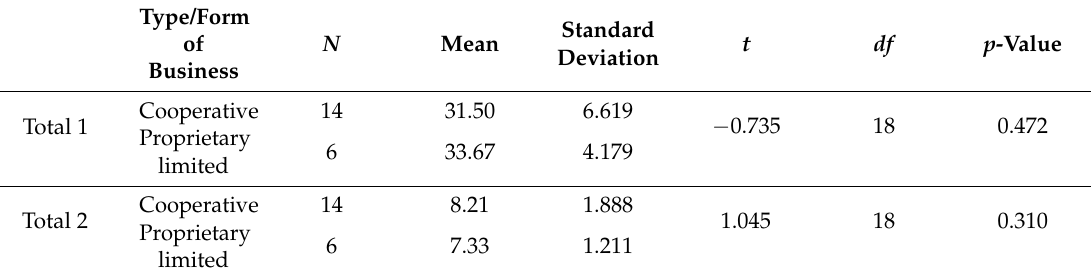
Table 7. Type/form of